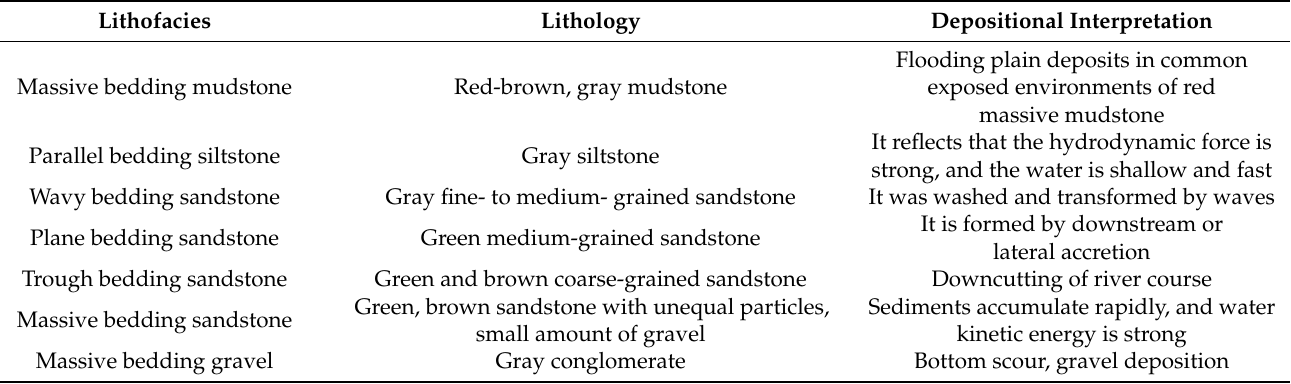
Table 1. Lithofacies types of the Jiucaiyuan Formation in the Beisantai Uplift. Lithofacies